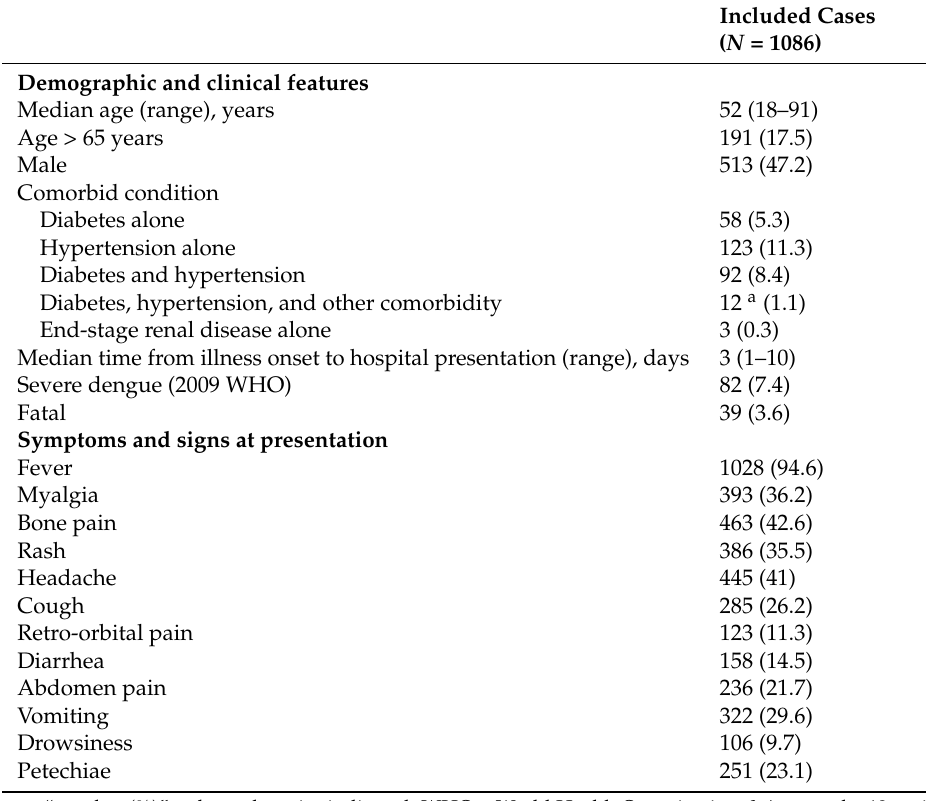
Table 1. Characteristics of adult patients with